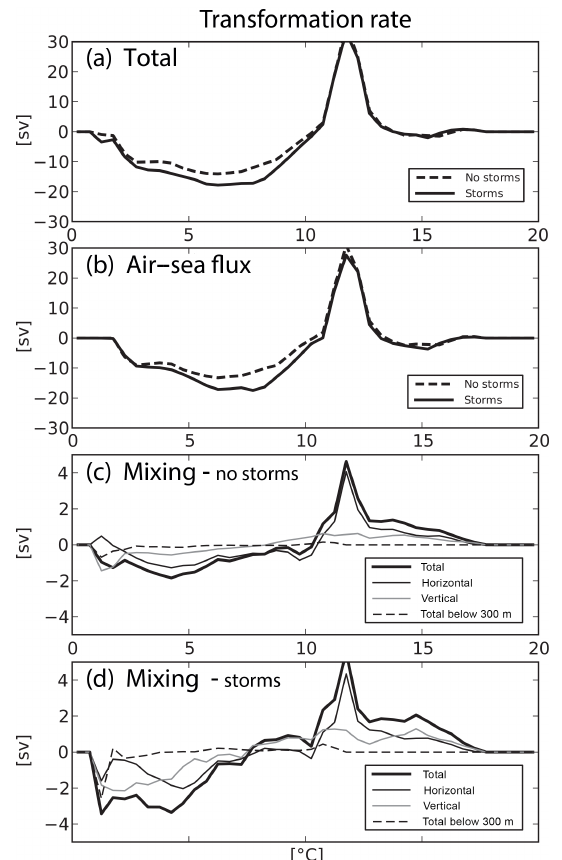
Figure 16. Transformation rate (in Sv): total (a) , contribution of air– sea fluxes (b) and diffuse fluxes across isotherms for the 2km sim- ulations without storms (c) and with storms (d) . The diffuse fluxes are separated into vertical (light gray) and lateral (black) contribu- tions. The dashed lines in (c) and (d) correspond to transformation by diffuses fluxes below 300m depth. Model transports have been multiplied by 10 in order to scale them to the full Southern